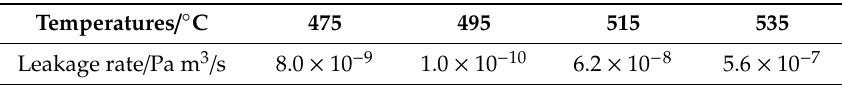
Table 4. Air tightness of the joints at di ff erent temperatures for 30 min.